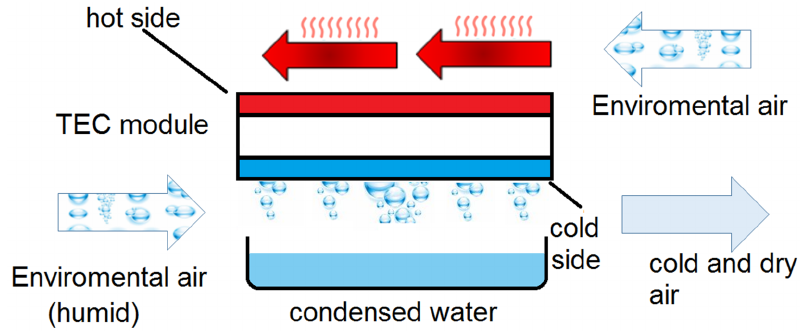
Figure 2. Thermoelectric cooler-based AWG working scheme.